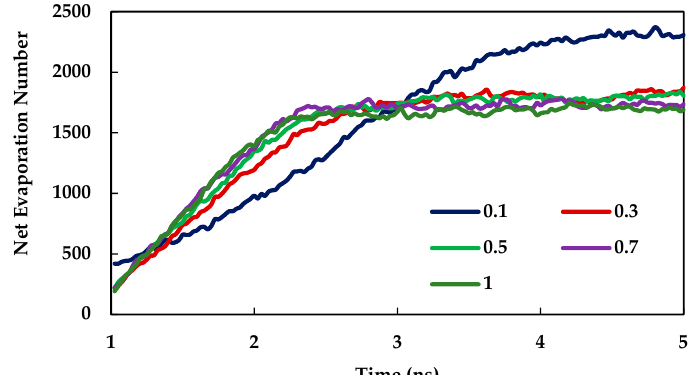
Figure 8. Density profile of argon at 4 ns for different surface wetting conditions.